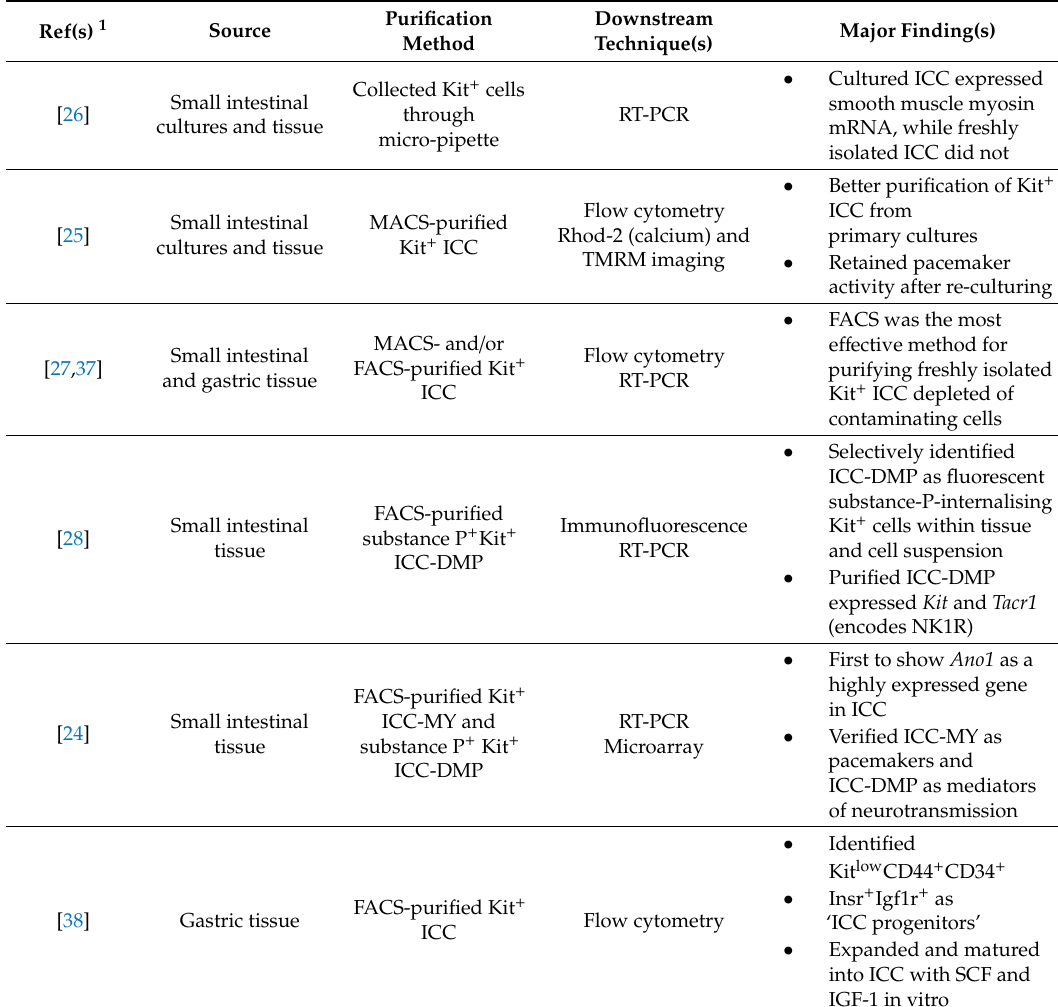
Table 1. Key molecular characterisation studies using interstitial cells of Cajal (ICC) isolated from murine GI